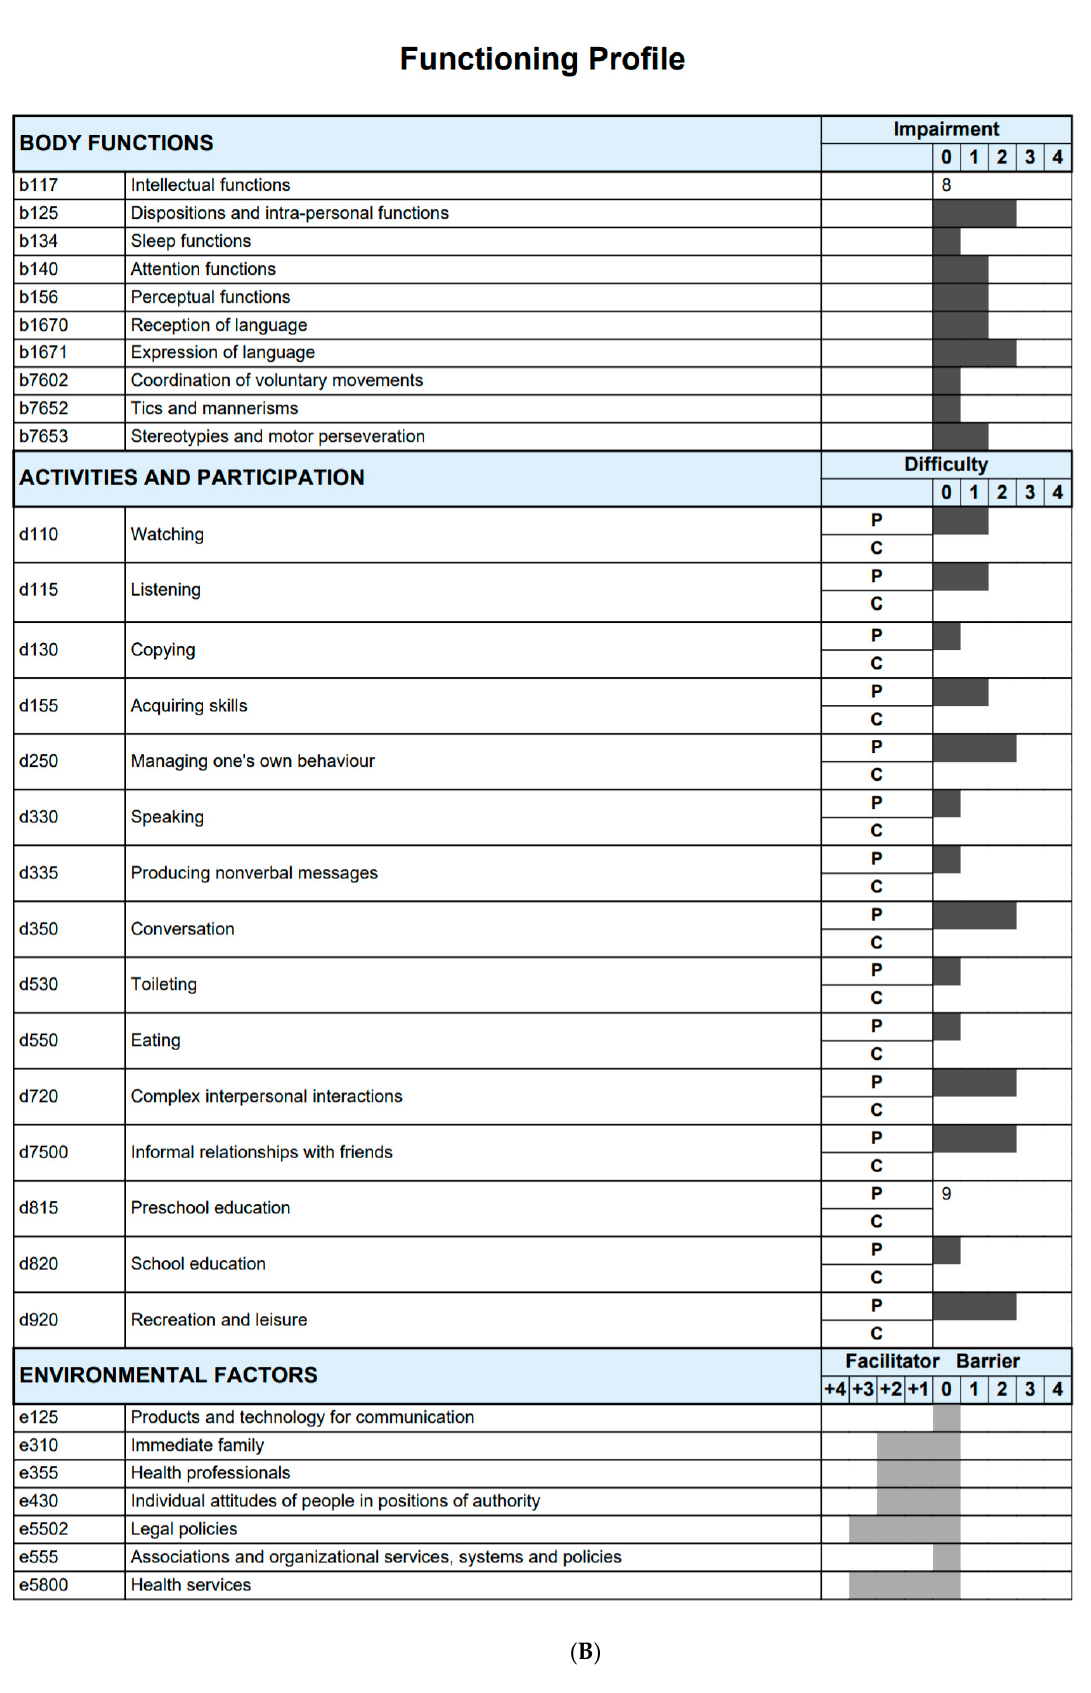
Figure 2. ( A ) Profile of functioning of children with ASD (autism spectrum disorder) < 6 years of age using TEA-CIFunciona version 1.0. ( B ) Profile of functioning of children with ASD 6 to 16 years of age using TEA-CIFunciona version